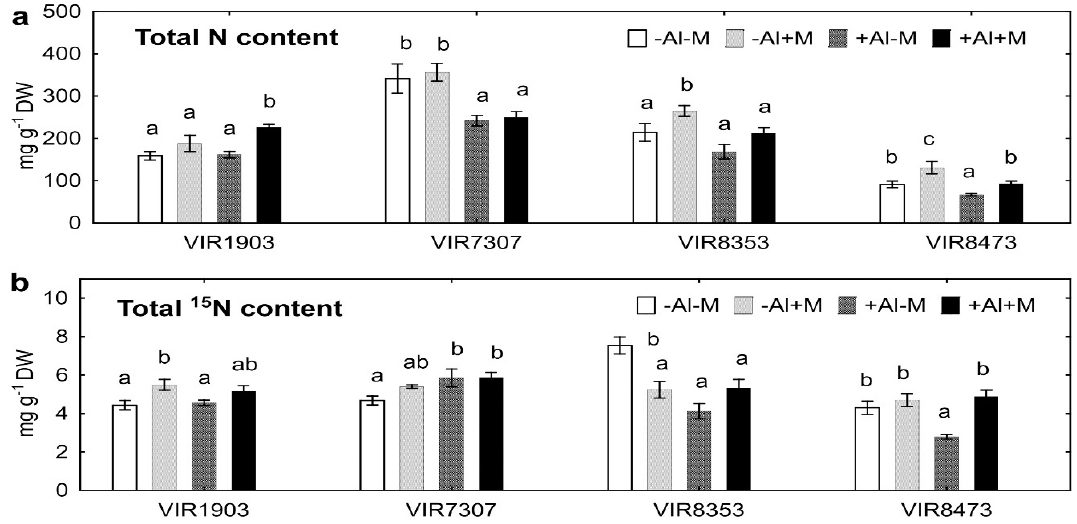
Figure 4. Total content (the sum of shoots and seeds) of N ( a ) and 15 N ( b ) of pea genotypes VIR1903, VIR7307, VIR8353 and VIR8473 inoculated with microbial consortium. See details in the legend to Figure 1.